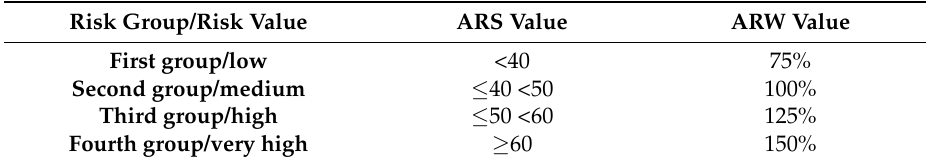
Table 2. The aggregate risk weight groups and their